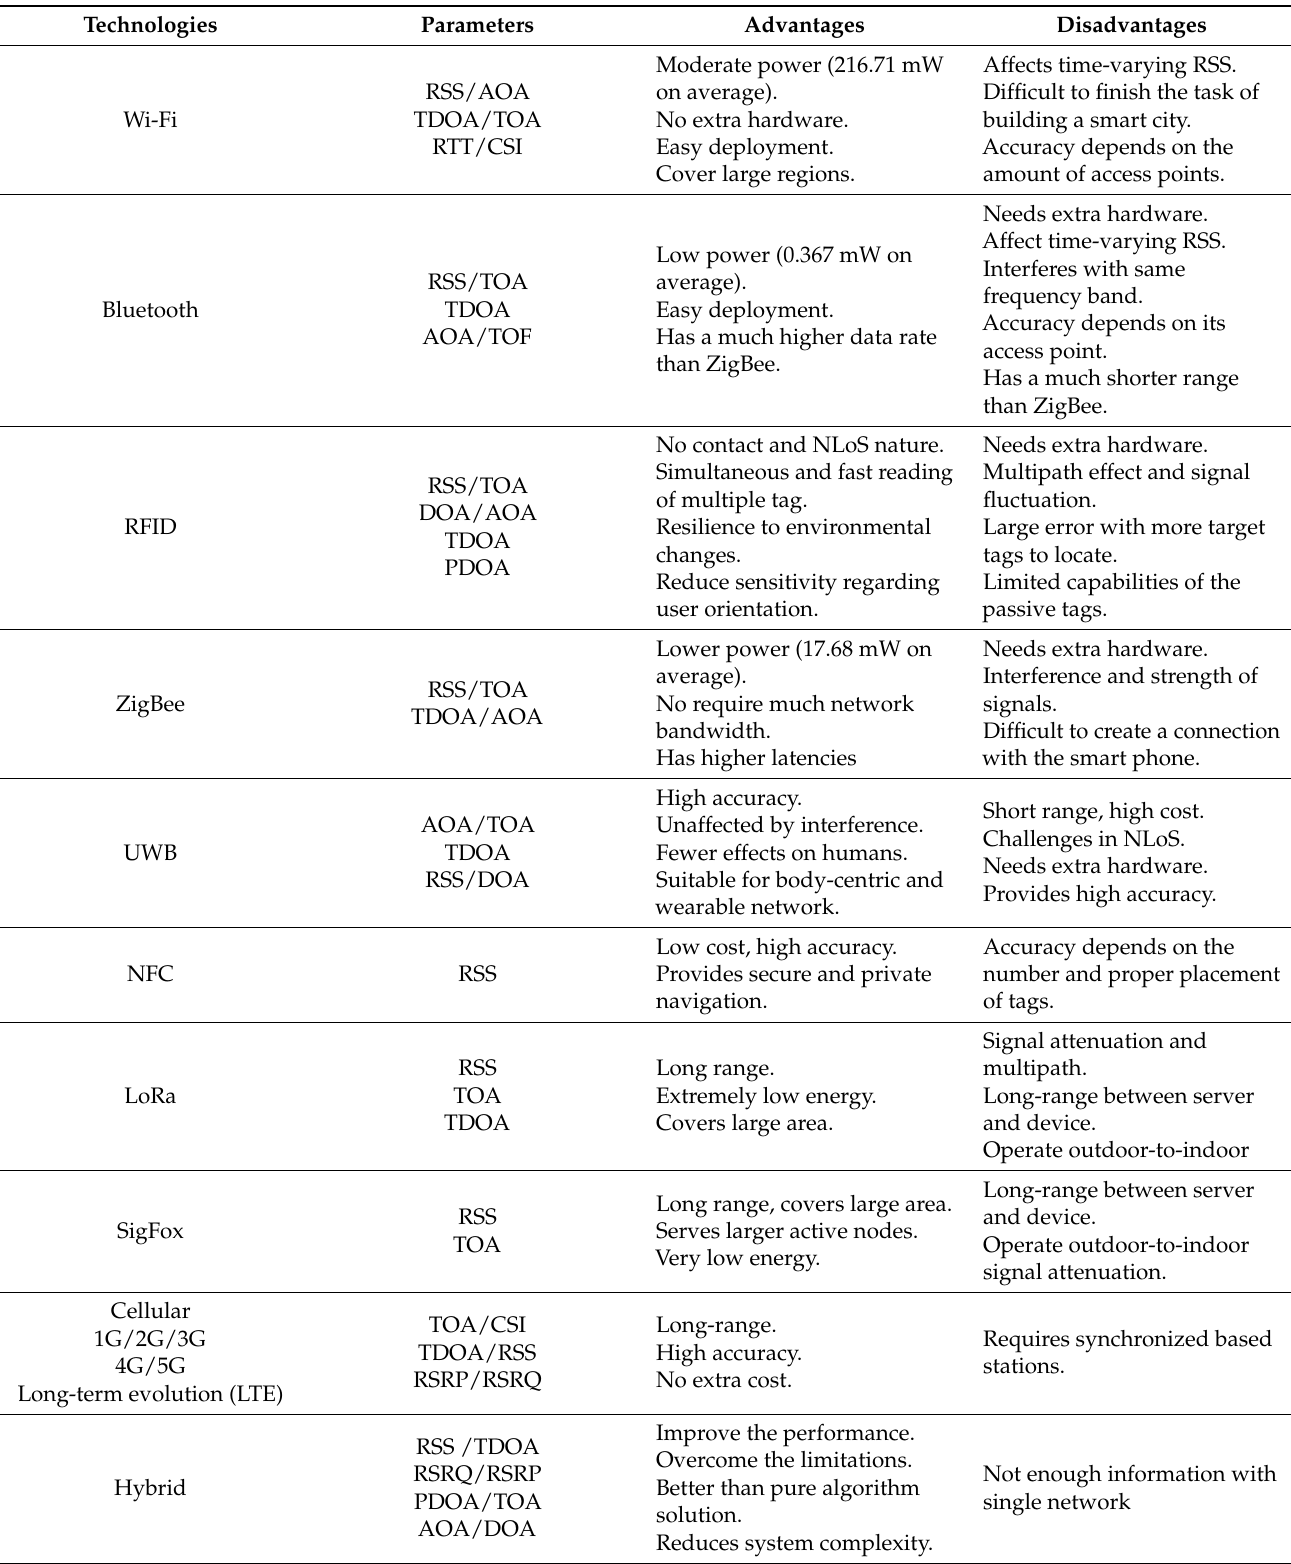
Table 2. Summary of radio-based technologies for indoor